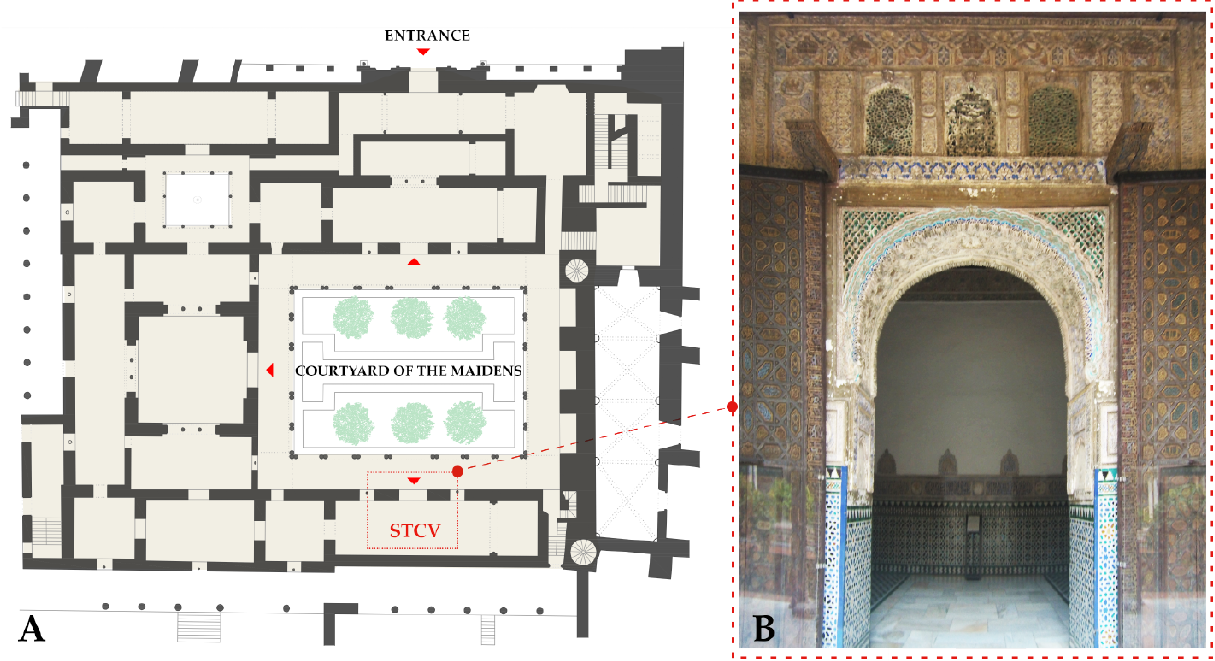
Figure 1. ( A ) Ground floor of the Palace of King Pedro I showing the location of the main courtyard and the entrance to the STCV. ( B ) Current state of the plasterwork of the entrance to the STCV. The space of the spandrel is quite complex, presenting great geometric and